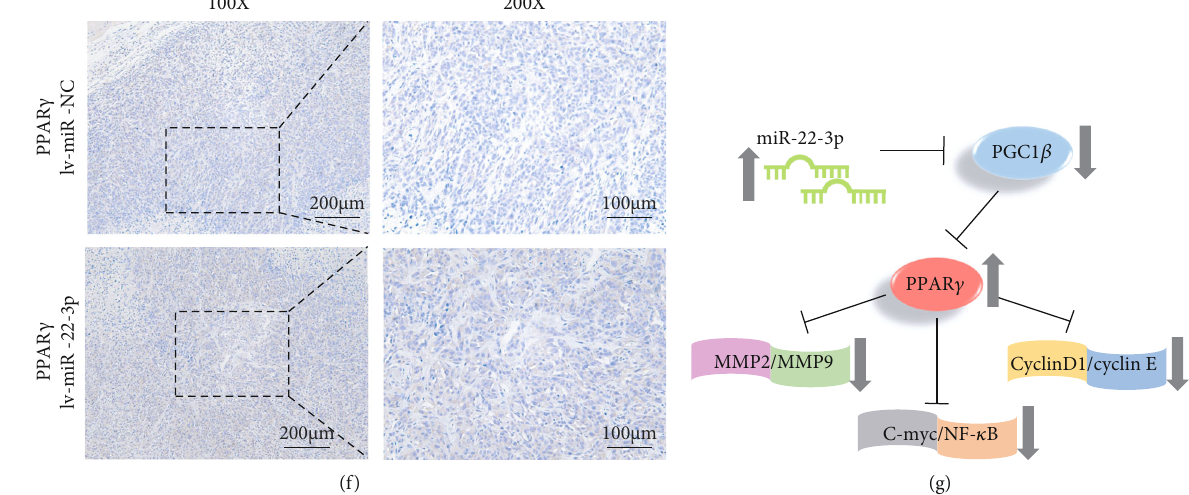
Figure 7: miR-22-3p suppressed BC tumor growth in vivo. (a) Overexpression of miR-22-3p in MDA-MB-231 cells was veri fi ed by RT- qPCR. (b) Representative images of xenograft tumors in nude mice. (c) The growth curves of xenografts. (d) Extract protein from tumors and measuring the expression of PGC1 β /PPAR γ by western blotting. (e, f) Immunohistochemistry (IHC) staining of PGC1 β /PPAR γ in xenografts. (g) The mechanism diagram was generated to illustrate the mechanism of miR-22-3p-PGC1 β -PPAR γ in BC. ∗ p < 0 : 05 ; ∗∗∗∗ p < 0 : 0001